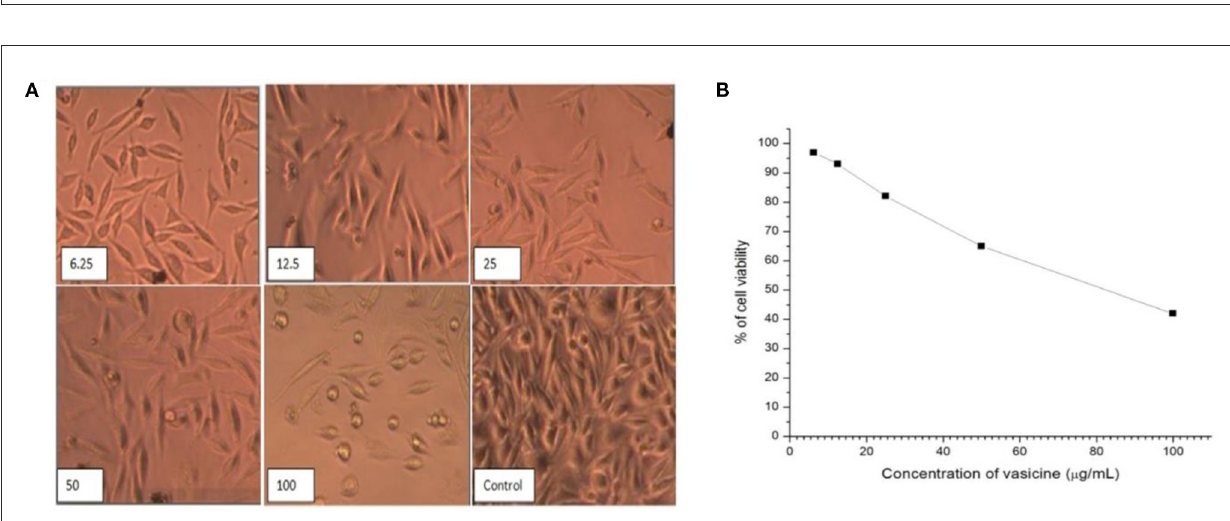
FIGURE9 (A) Direct microscopic view of cytotoxic activity of vasicine at various concentrations (6.25, 12.5, 25, 50, 100 µ g/ml) in comparison with the control value. (B) Cell viability (%) in MTT assay on Human Fibroblast Cell line (IC 50 Value = 82.5 µ